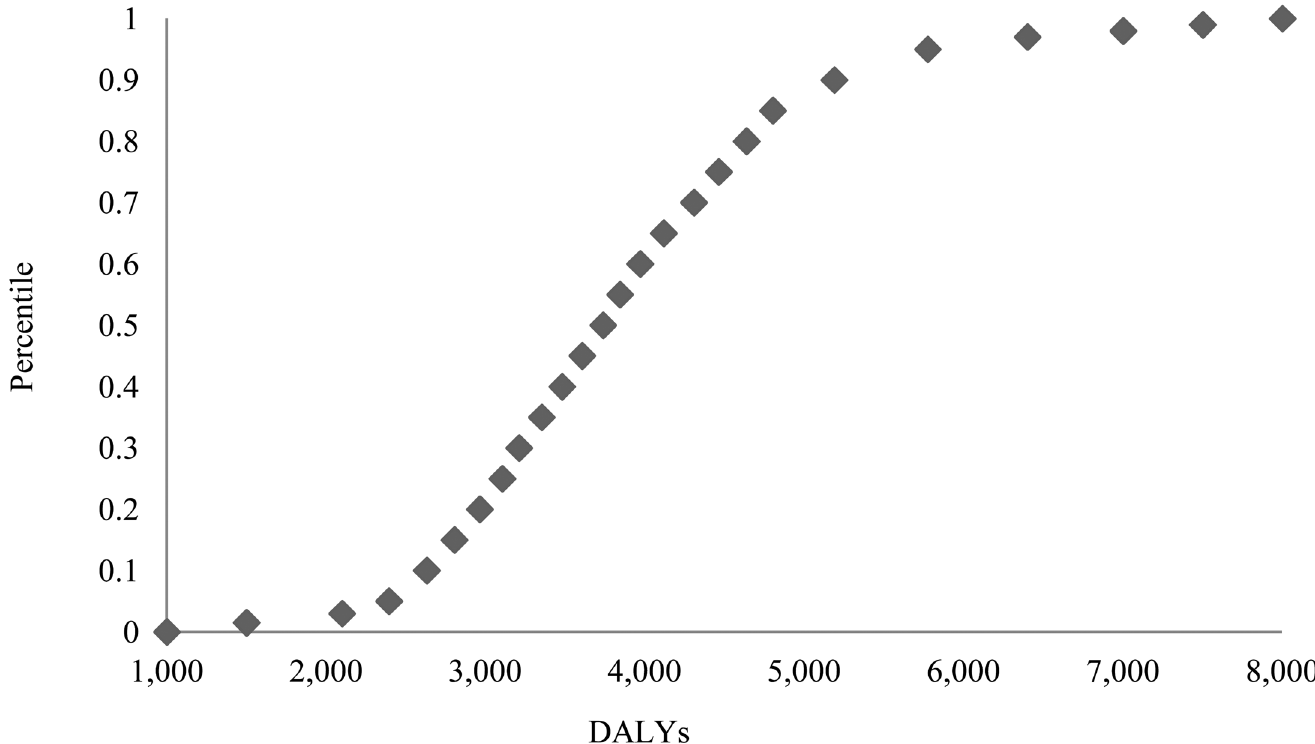
Fig 5. Cumulative ascending curve of the probabilistic sensitivity analysis of TBE burden expressed in total DALYs from the population perspective, reflecting the likelihood (y-axis) of being below a specified total DALYs impact (x-axis).